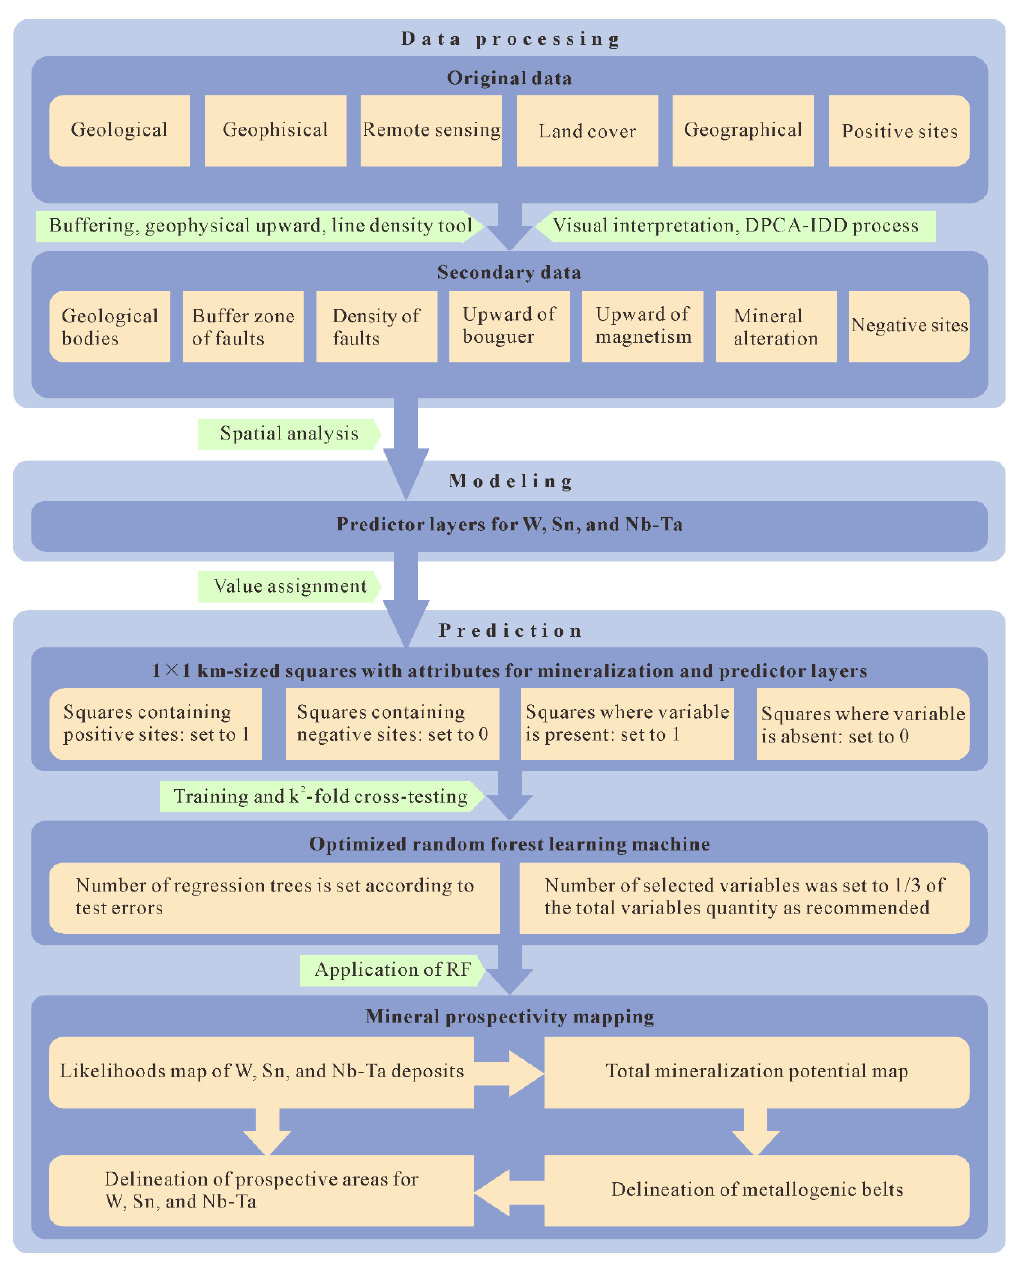
Figure 2. Flowchart of regional quantitative MPM in this study. Table 1. List of data.